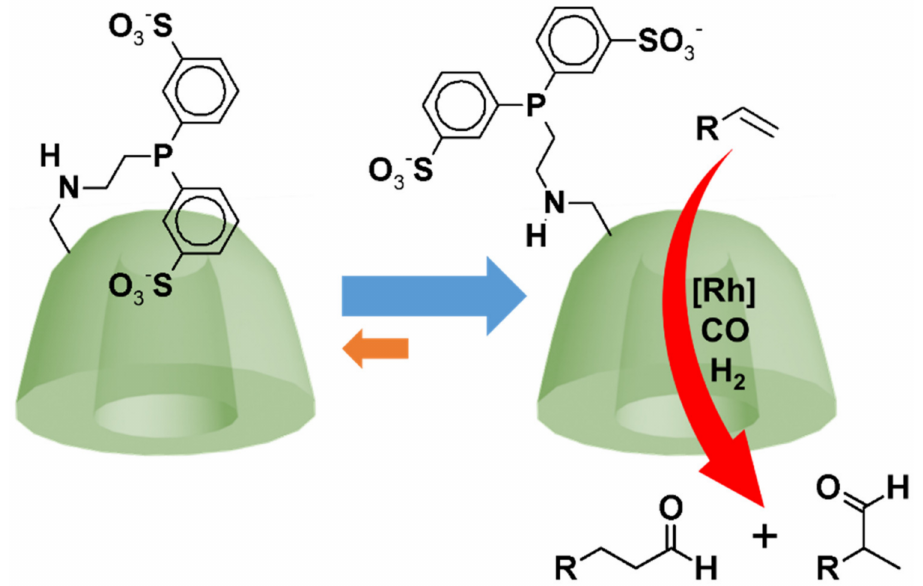
Figure 18. The principle of hydroformylation of higher olefins mediated by a CD-based organometallic